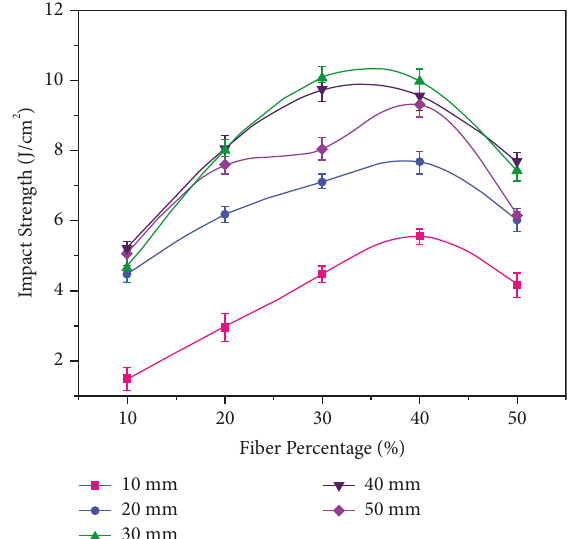
Figure 4: Effect of fiber length and weight percentage on the impact strength.